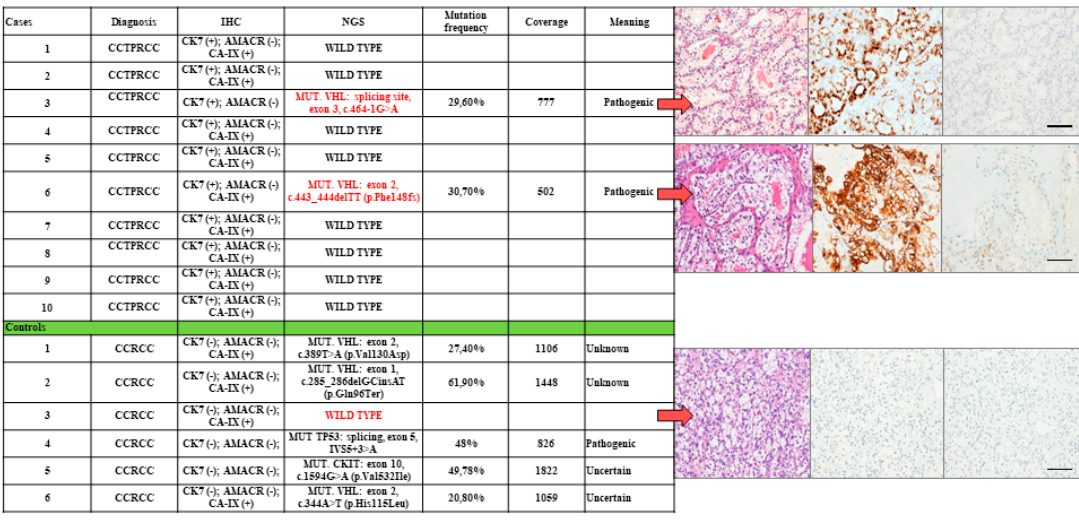
Figure 2. Comparative histological, immunohistochemical, and mutational profiles of 10 cctpRCC cases and six ccRCC controls. The histological and immunohistochemistry (IHC) features of the three cases most discordant with next generation sequencing (NGS) are indicated by arrows (scale bar 50 microns).